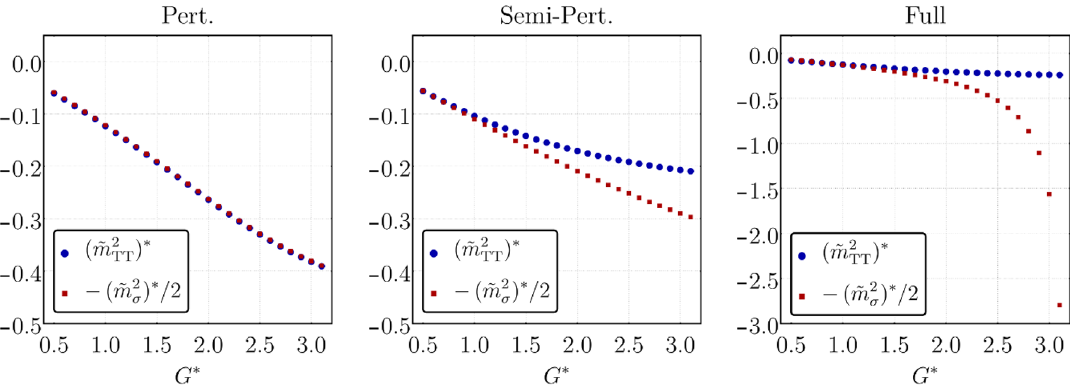
Figure 3 . Fixed point solutions for the partial system composed by eqs. (3.9a) and (3.9b). In this case, the (cid:12)xed point value for the dimensionless Newton’s coupling, G (cid:3) , appears as an external variable.